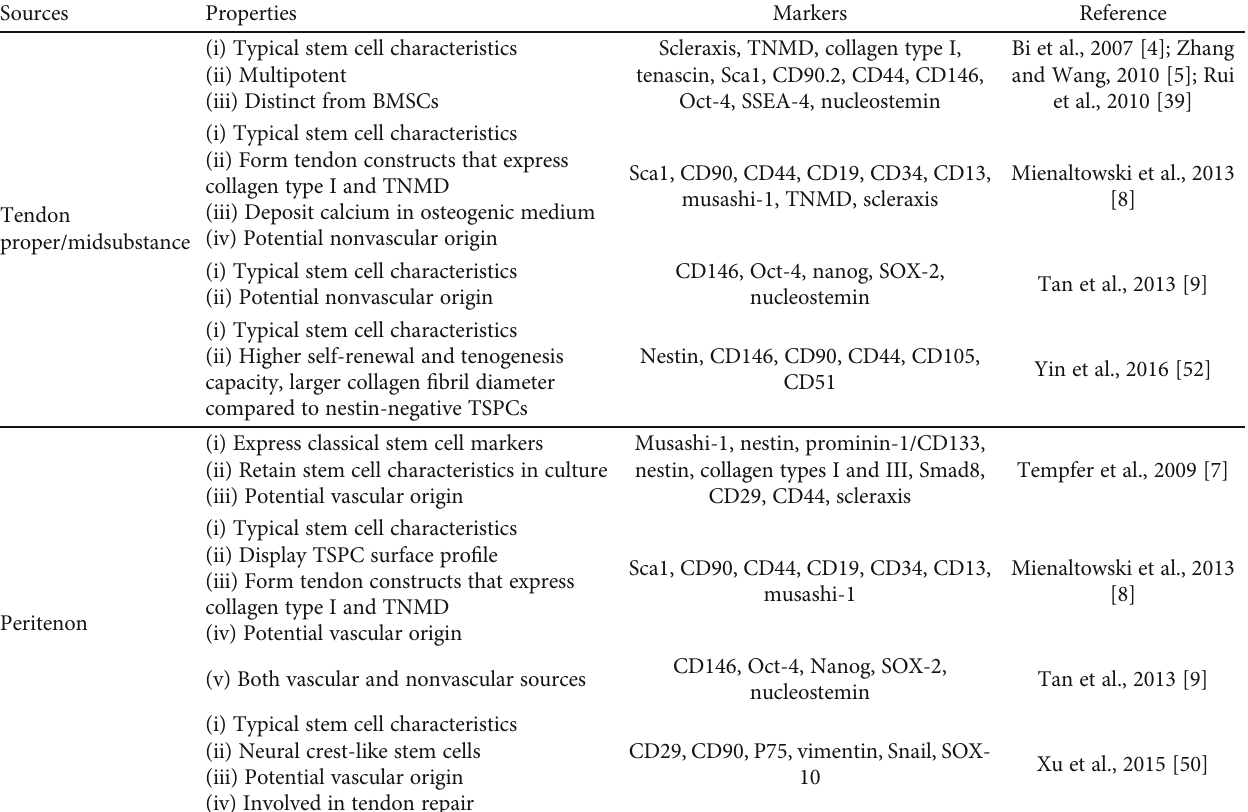
Figure 1: A simpli fi ed model of tendon structure adapted from Speisz et al. [47] showing fascicular matrix (FM), interfascicular matrix (IFM), and paratenon. The elongated tenocytes are located in FM in between fi bers. The TSPCs from the tendon proper are presumably located in IFM; its exact location is yet to be determined, however. Table 1: Sources and properties of